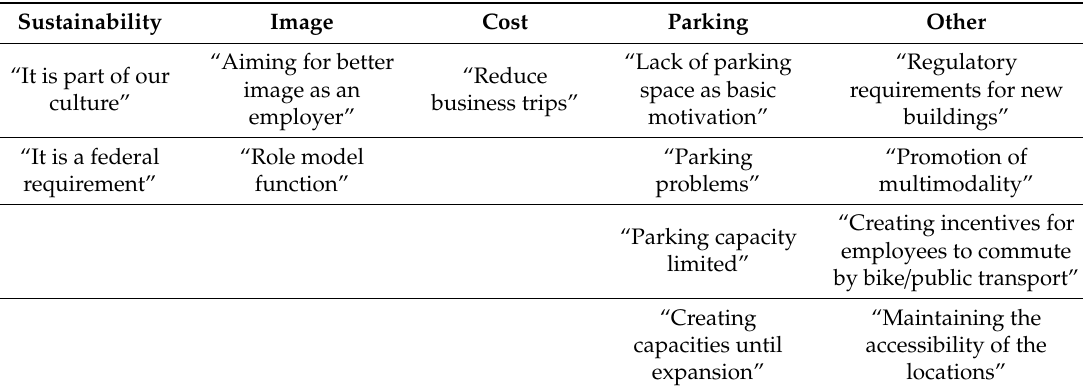
Table 2. Reasons for company mobility management, open-format question ( n =